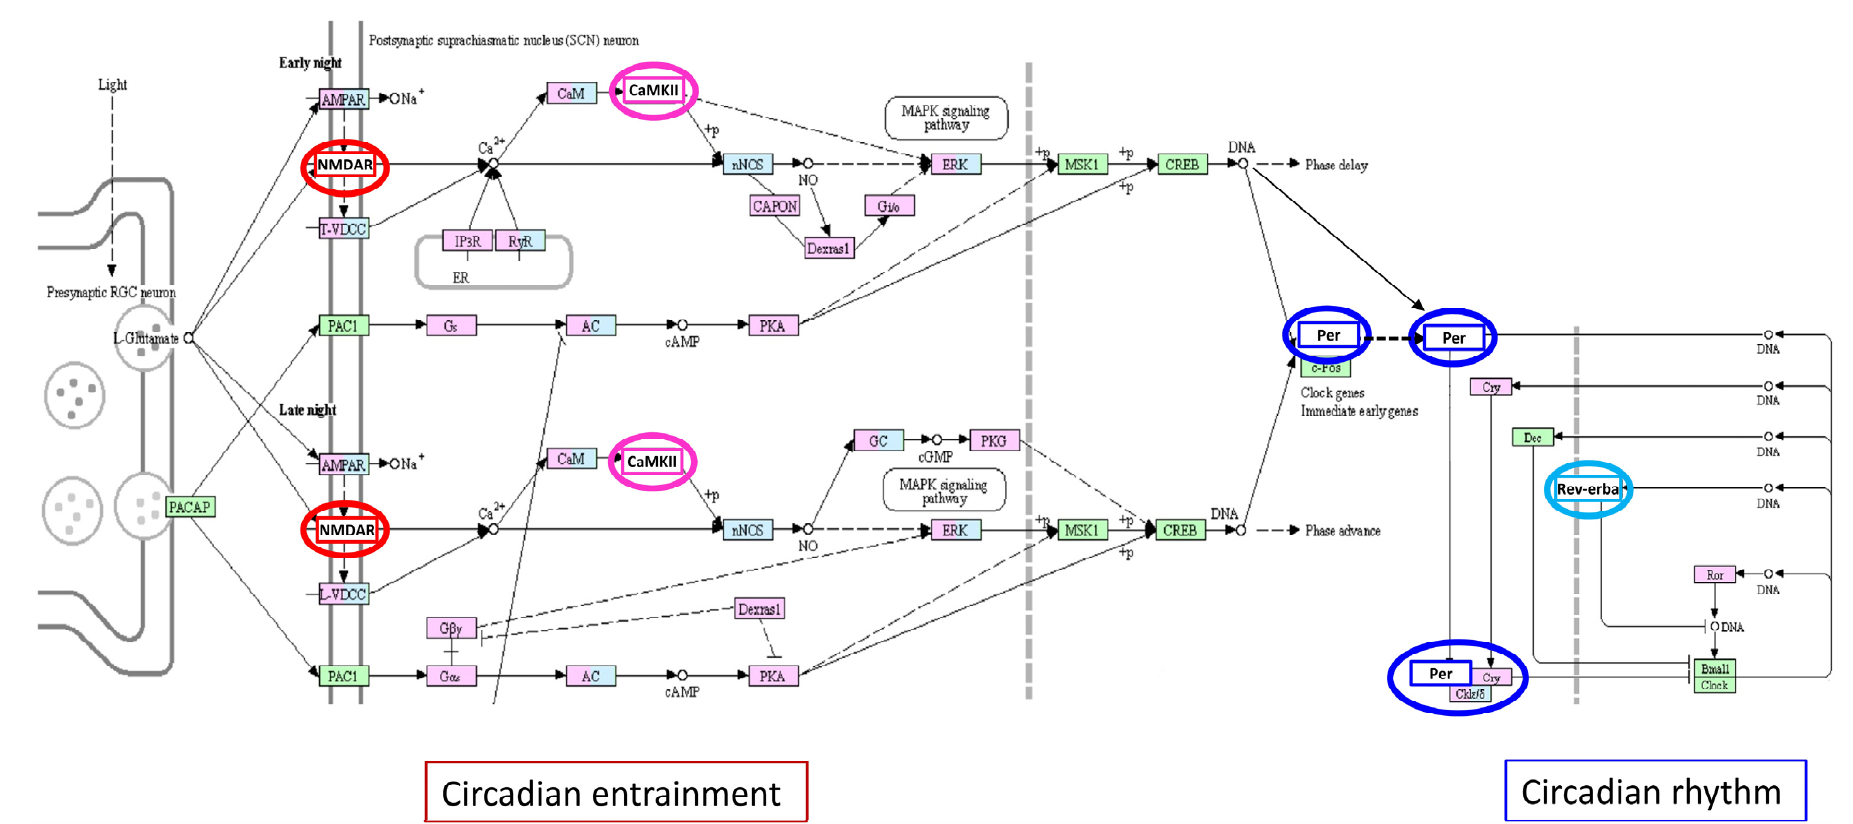
Figure 5. The “circadian entrainment” and “circadian rhythm” KEGG pathway members encoded by genes differentially expressed in the wall of IJV ( CAMK2G, GRIN2A, GRIN2B, PER3, NR1D1 ). In the KEGG graph, the proteins encoded by these genes are marked as colored circles: the red circle indicates the glutamate ionotropic receptor NMDA that contains subunit 2A and 2B coded by GRIN2A, GRIN2B ; the pink circle indicates the CaMKII γ protein kinase coded by CAMK2G ; the blue circle indicates the PER proteins among which the period circadian clock 3 is coded by PER3 ; the light blue circle indicates the Rev-Erb α protein coded by NR1D1 . In accordance with KEGG color codes, pink rectangles indicate disease genes; light blue rectangles indicate drug target; pink/light blue rectangles indicate disease gene and drug target elements; green rectangles indicate specific signaling pathway elements.